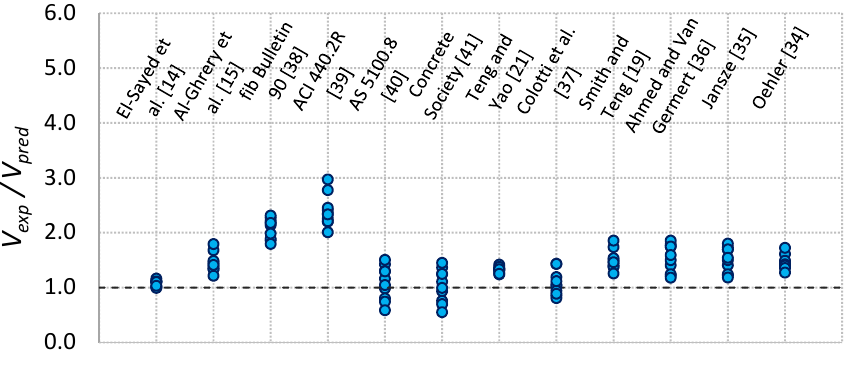
Figure 11. Comparison of experimental and predicted plate end debonding capacity using shear- based models.